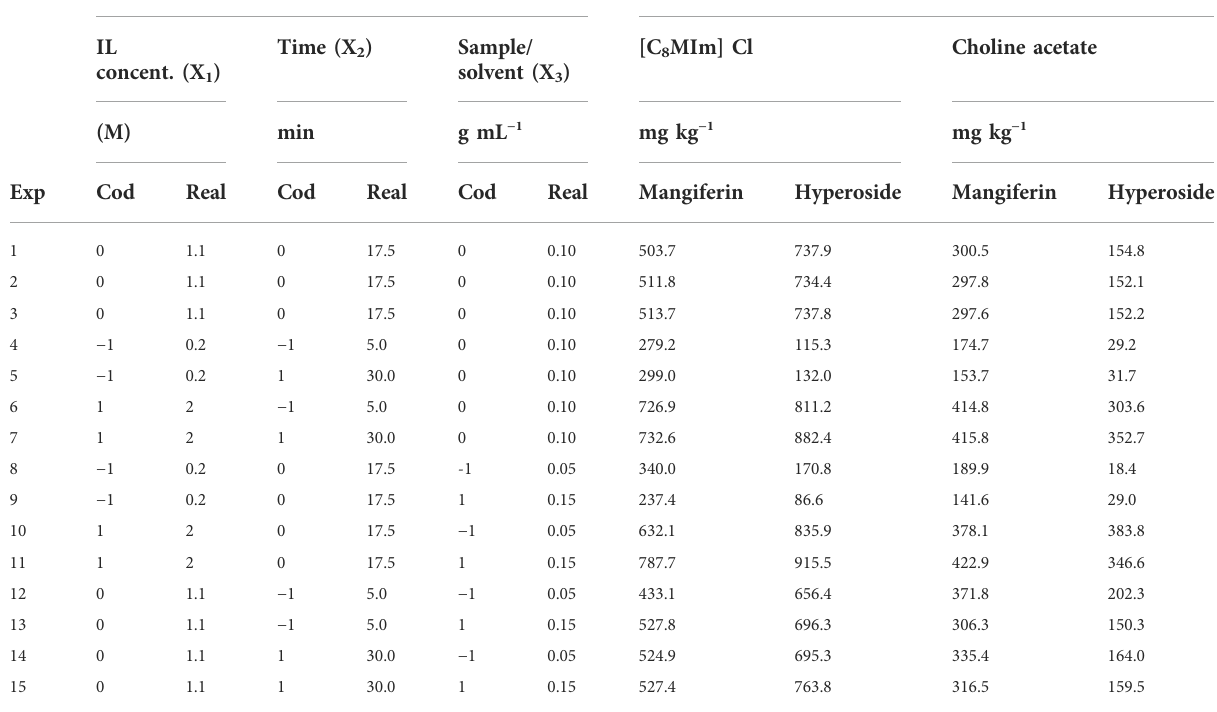
TABLE 3Box-Behnkenexperimentaldesign and extractionrecoveryresponsesforthe optimizationofHAEwith [C 8 MIm]Clandcholineacetateionic liquids.